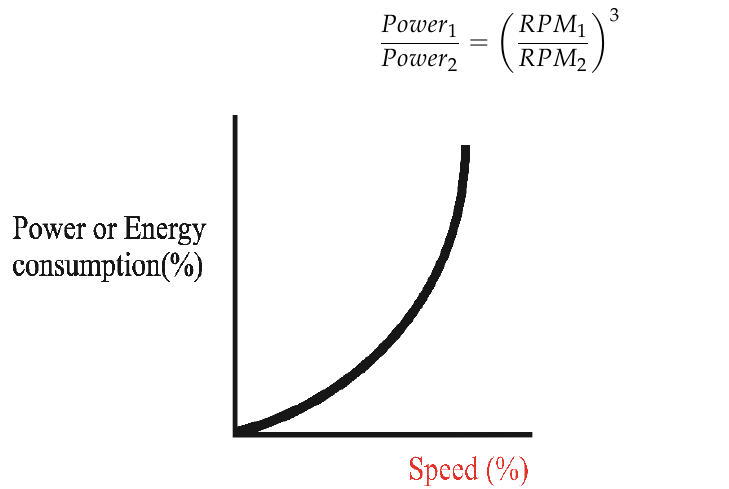
Figure 1. Characteristics of speed and energy consumption of a squirrel cage induction motor [2].